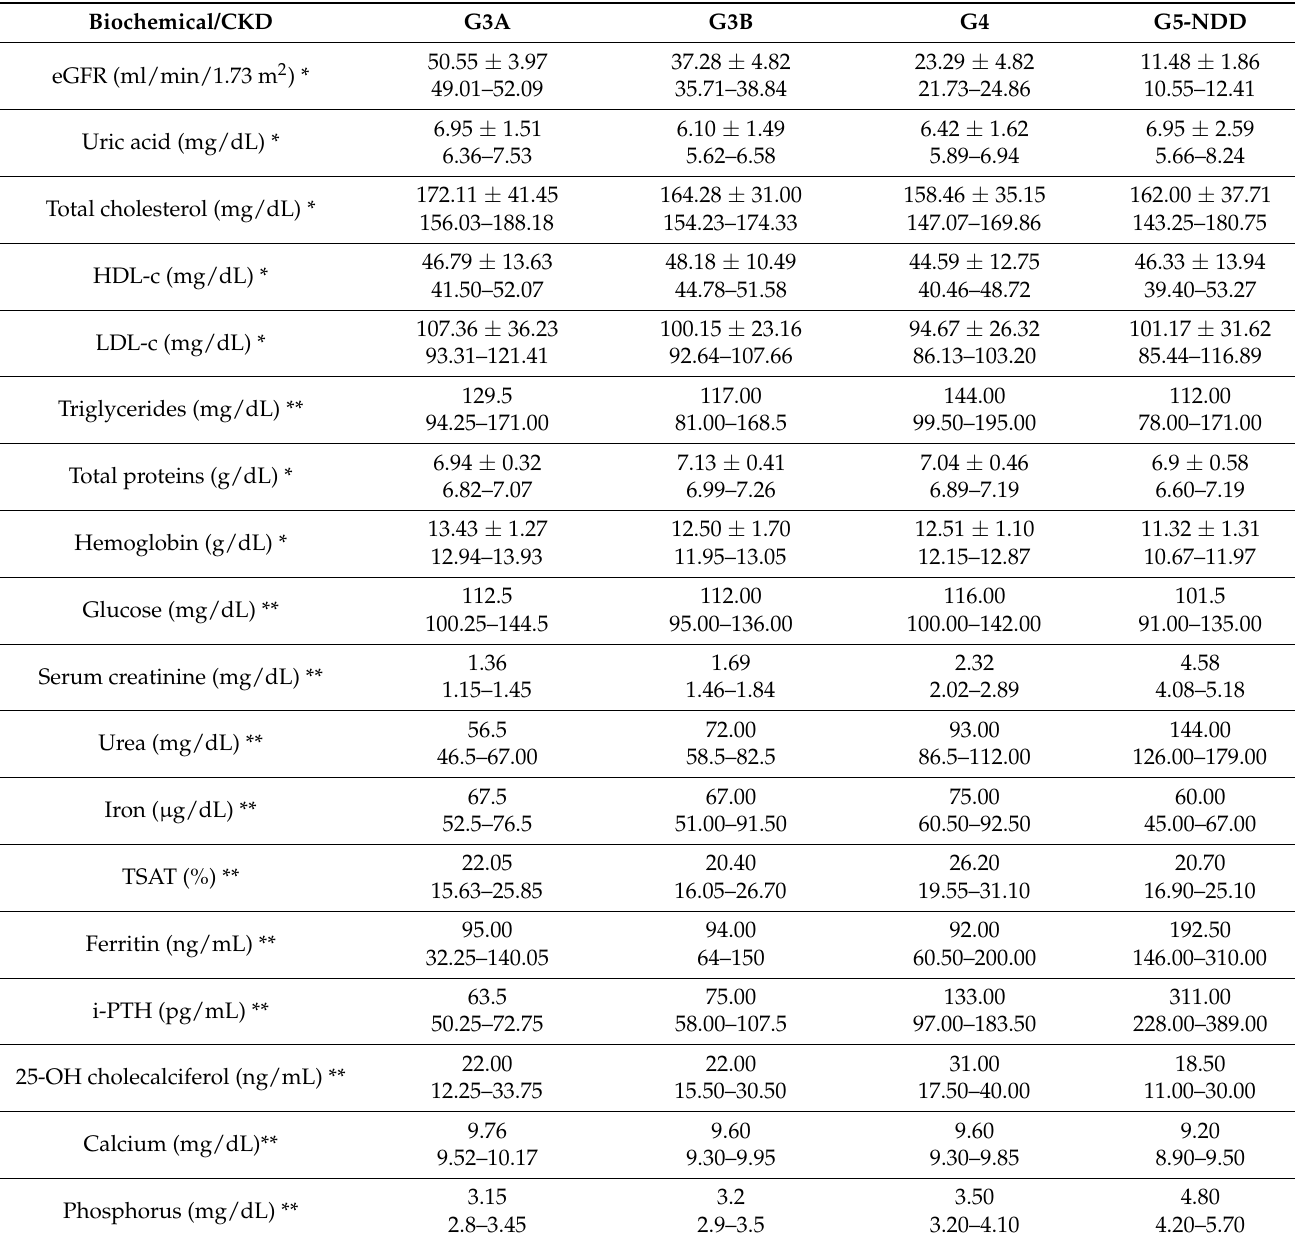
Table 4. Basic biochemical profile of the renal population by